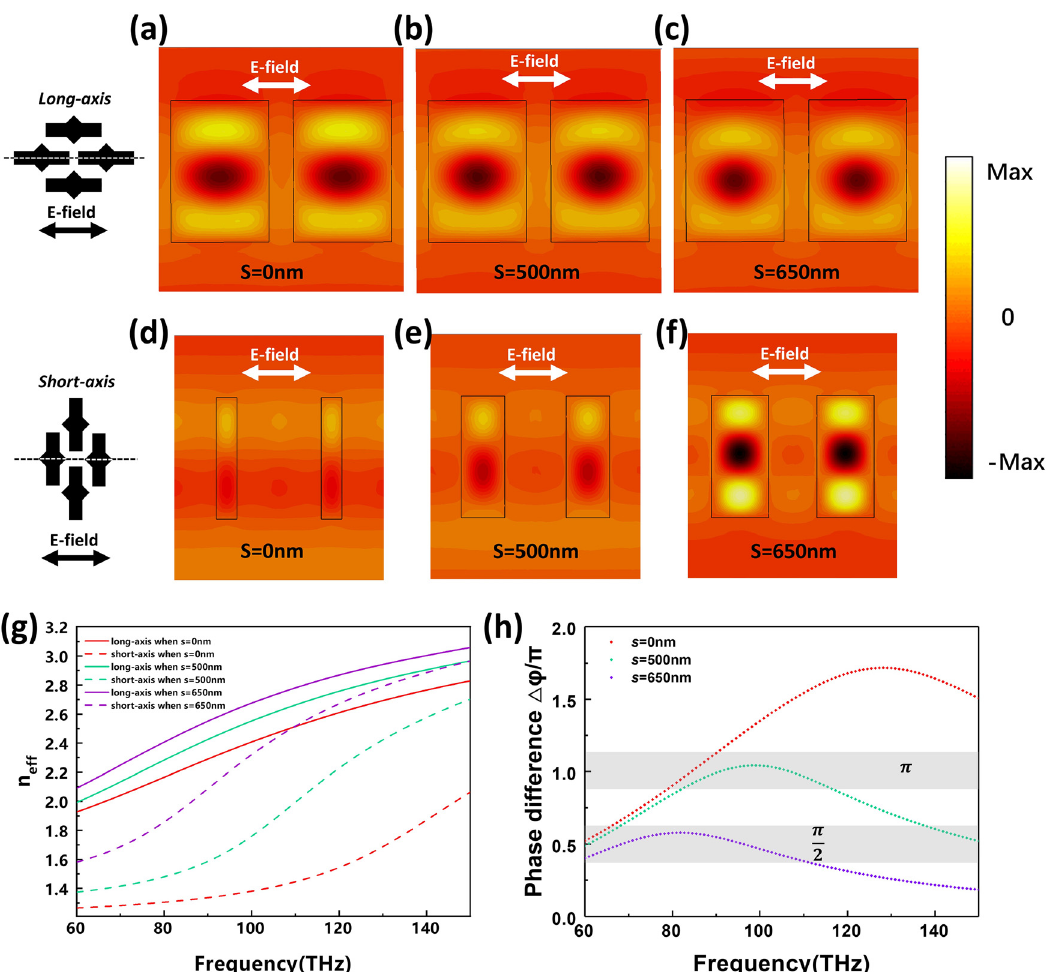
Figure 3: Underlying physics in the process of WP type transformation. (a) – (c)/(d) – (f) Simulated instantaneous magnetic field strength distributions along the long/short axes of the CNs when s = 0, 500 and 650nm,respectively.(g)Simulatedeffectiverefractiveindexofpolarizedincidencealonglongandshortaxeswhen s =0,500and650nm.(h) Calculated phase difference between long and short axes when s = 0, 500 and 650